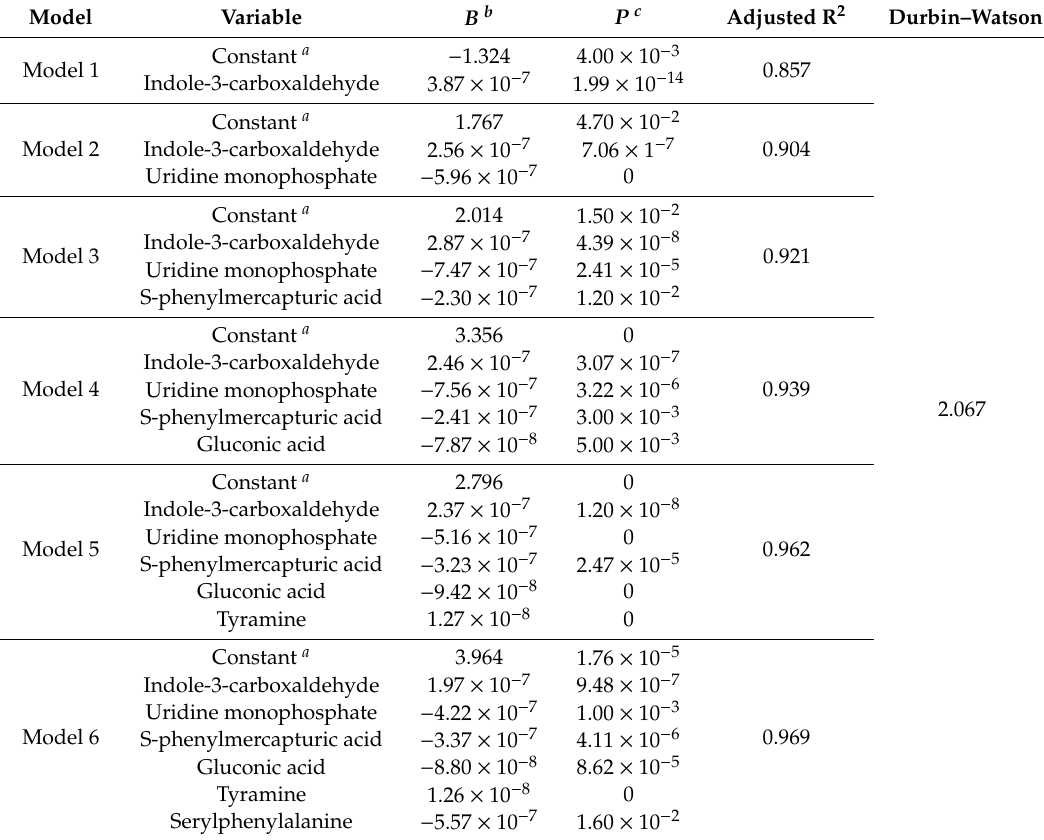
Table 2. Multivariate linear regression analysis of the 38 potential